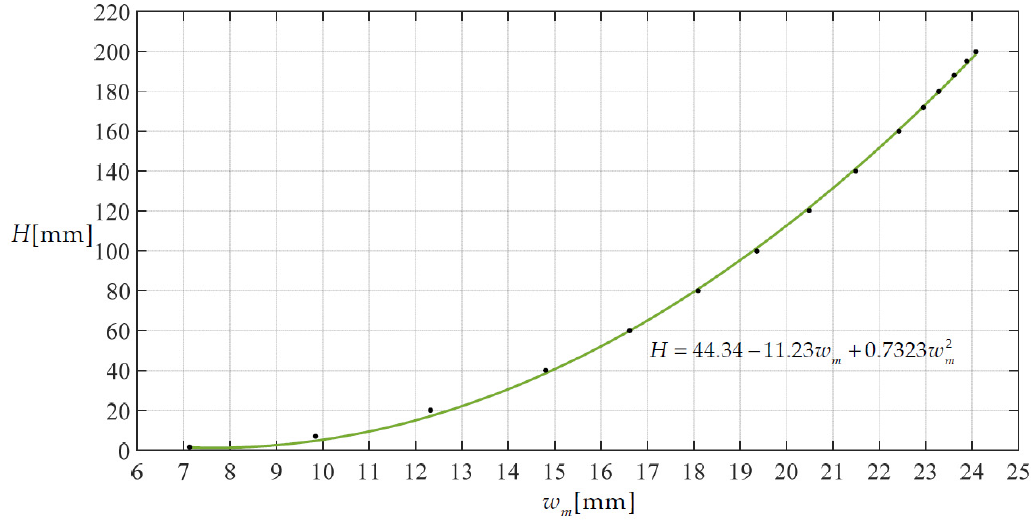
Figure 10 Figure 10. A scatter diagram describing the relationship of height H and maximum deflection w m .